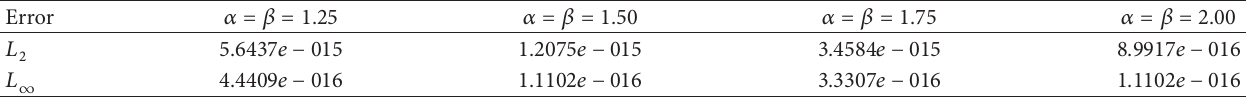
Table 1: Errors of Example 24 for different values of 𝛼 and 𝛽 with 𝑀 = 𝑀 󸀠 = 4